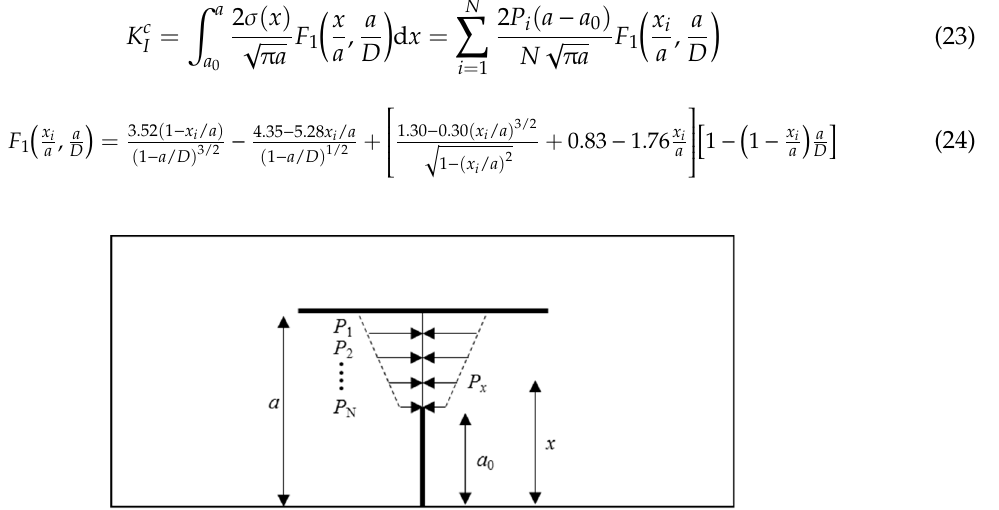
Figure 20. Dissociation of the cohesion in propagating fractures.